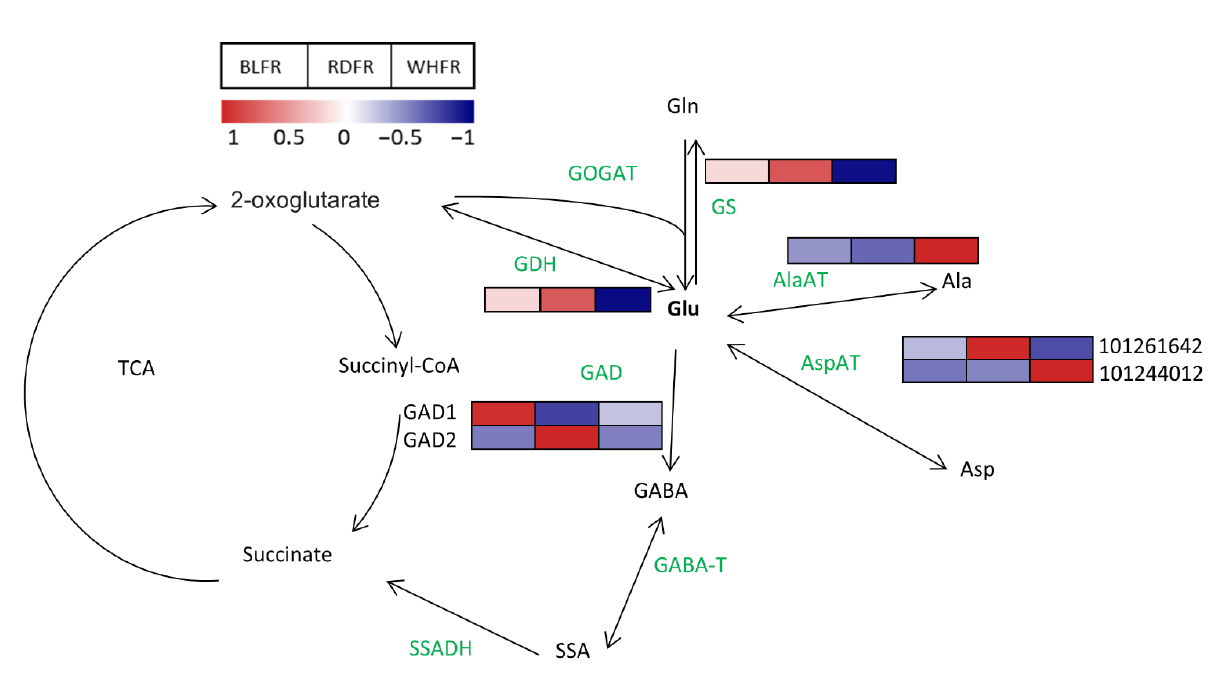
Figure 9. Transcriptomic profiles of genes involved in the Glu metabolism pathway. Red and blue rectangles indicate higher and lower levels, respectively, than the mean of all treatments. Values indicate the z-score in the legend. The experimental data were subjected to an independent t -test at p < 0.05. Significant differences are found in the transcription level of GDH in RDFR vs. WHFR, GAD1 in BLFR vs. others, GAD2 in RDFR vs. others, AspAT (Gene ID: 101261642) in RDFR vs. WHFR, AspAT (Gene ID: 101244012) in WHFR vs. others, AlaAT in RDFR vs. WHFR, and GS in RDFR vs. WHFR. BLFR, RDFR, and WHFR refer to blue, red, and white light-treated fruits, respec- tively.